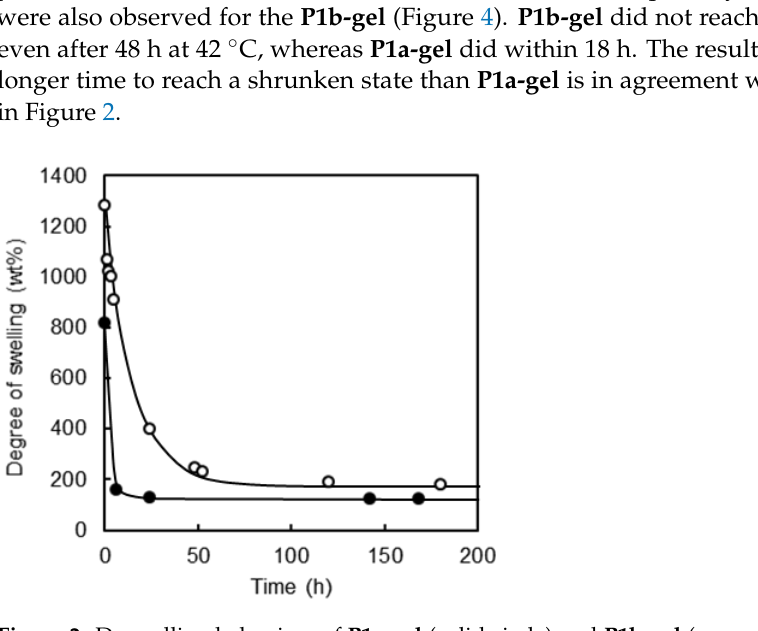
Figure 2. Deswelling behaviors of P1a-gel (solid circle) and P1b-gel (open circle) after soaking in chloroform at 42 °C.